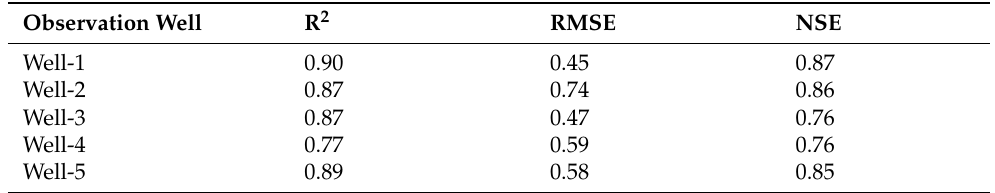
Table 5. Error indicators between observed groundwater level and simulated value in different distribution areas.